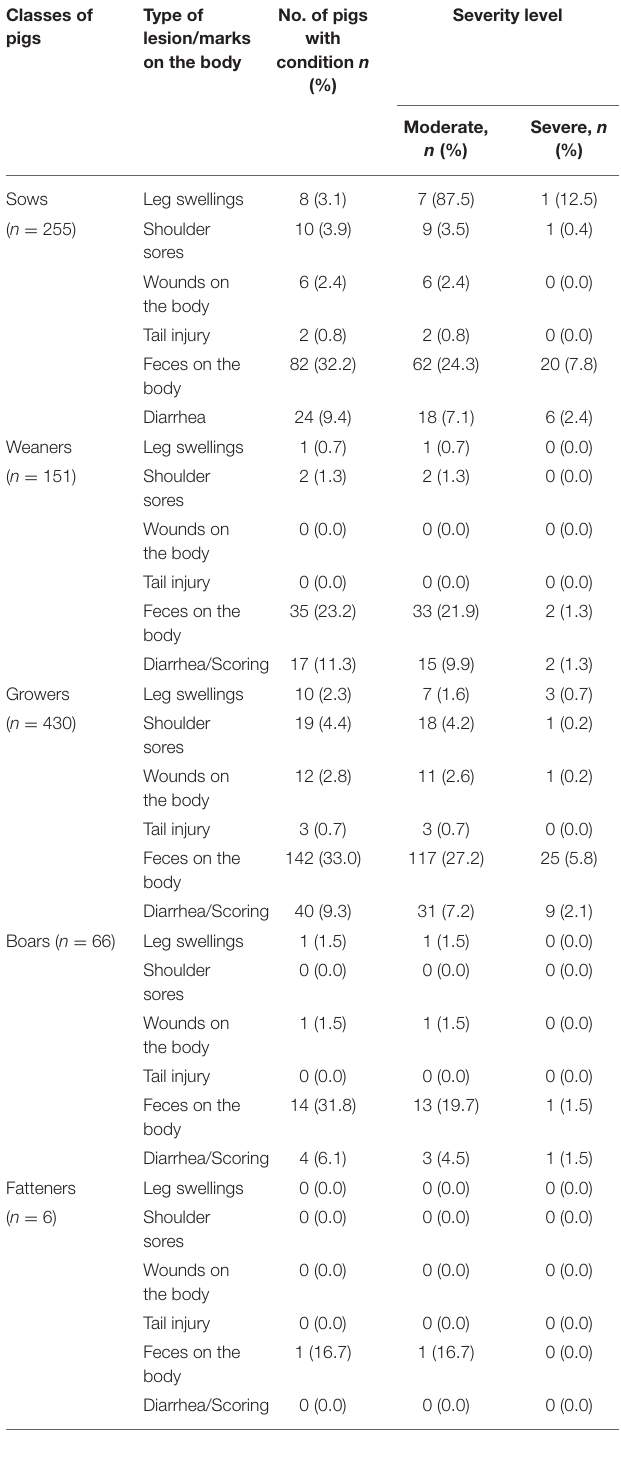
TABLE 5 | Physical injuries in all classes of pigs other than piglets. Classes of